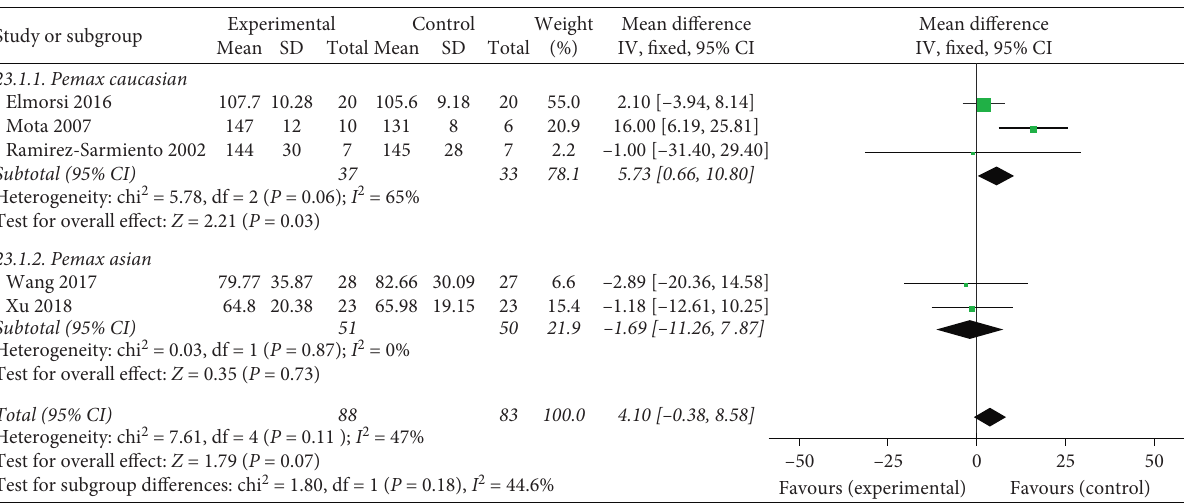
Figure 5: Effects of breathing exercises on P